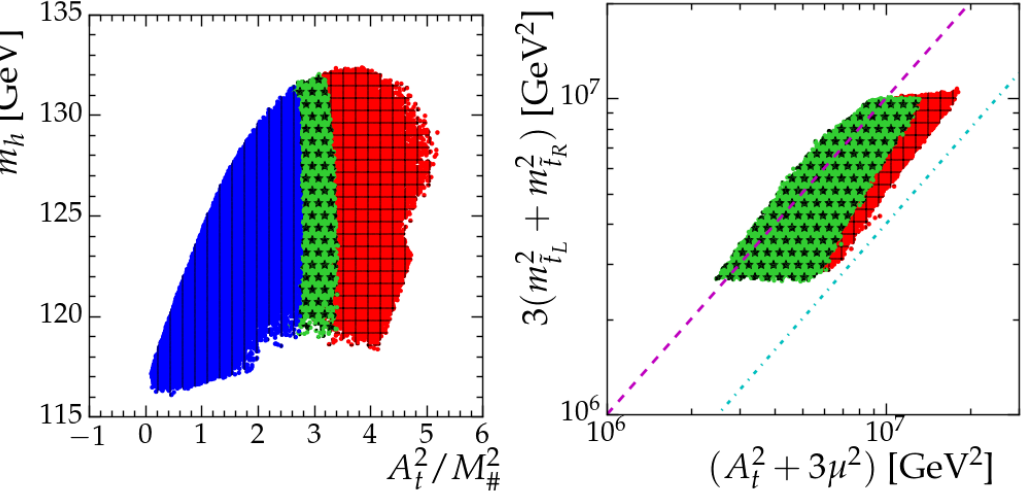
Figure 2 . Left: the variation of m h against A 2 =M 2 for three (cid:12)eld potential. Right: the variation t # of 3( m 2 + m 2 ) with A 2 + 3 (cid:22) 2 for the three (cid:12)eld. The dashed (magenta) line corresponds to the t ~ t L ~ t R analytic bound and the dot-dashed (cyan) line corresponds to the empirical bound. Points that correspond to the EWSB vacuum being unstable are given in red (checkered), meta-stable in green (stars) and stable in blue (vertical lines).